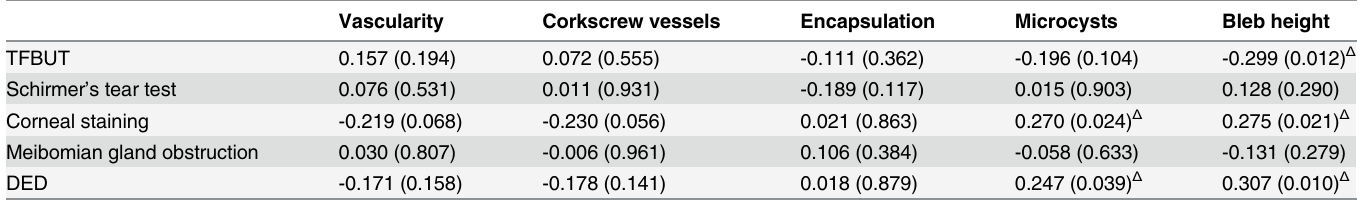
Table 8. Spearman ’ s correlation coefficient ( P -value) for the correlation between filtering bleb morphology and ocular surface